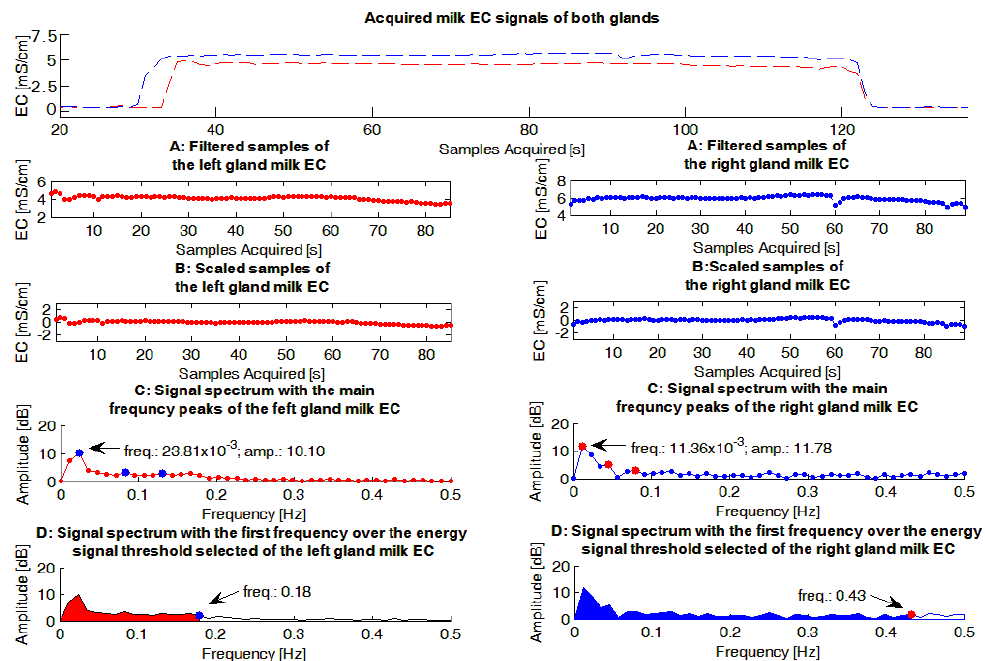
Figure 2. Example of gauges obtained from the milk electrical conductivity (EC) signals acquired within a milking. Furthermore, the following graphs report: ( A ) the sequences without the signal samples related to the start and the end of milking; ( B ) the sequences where the mean value of each sequence have been subtracted to each signal sample acquired; ( C ) the Fourier frequency spectra of the previous sequences of signal samples and the three main frequency peaks and ( D ) the bandwidth length of the signal (also colored to be easily highlighted).